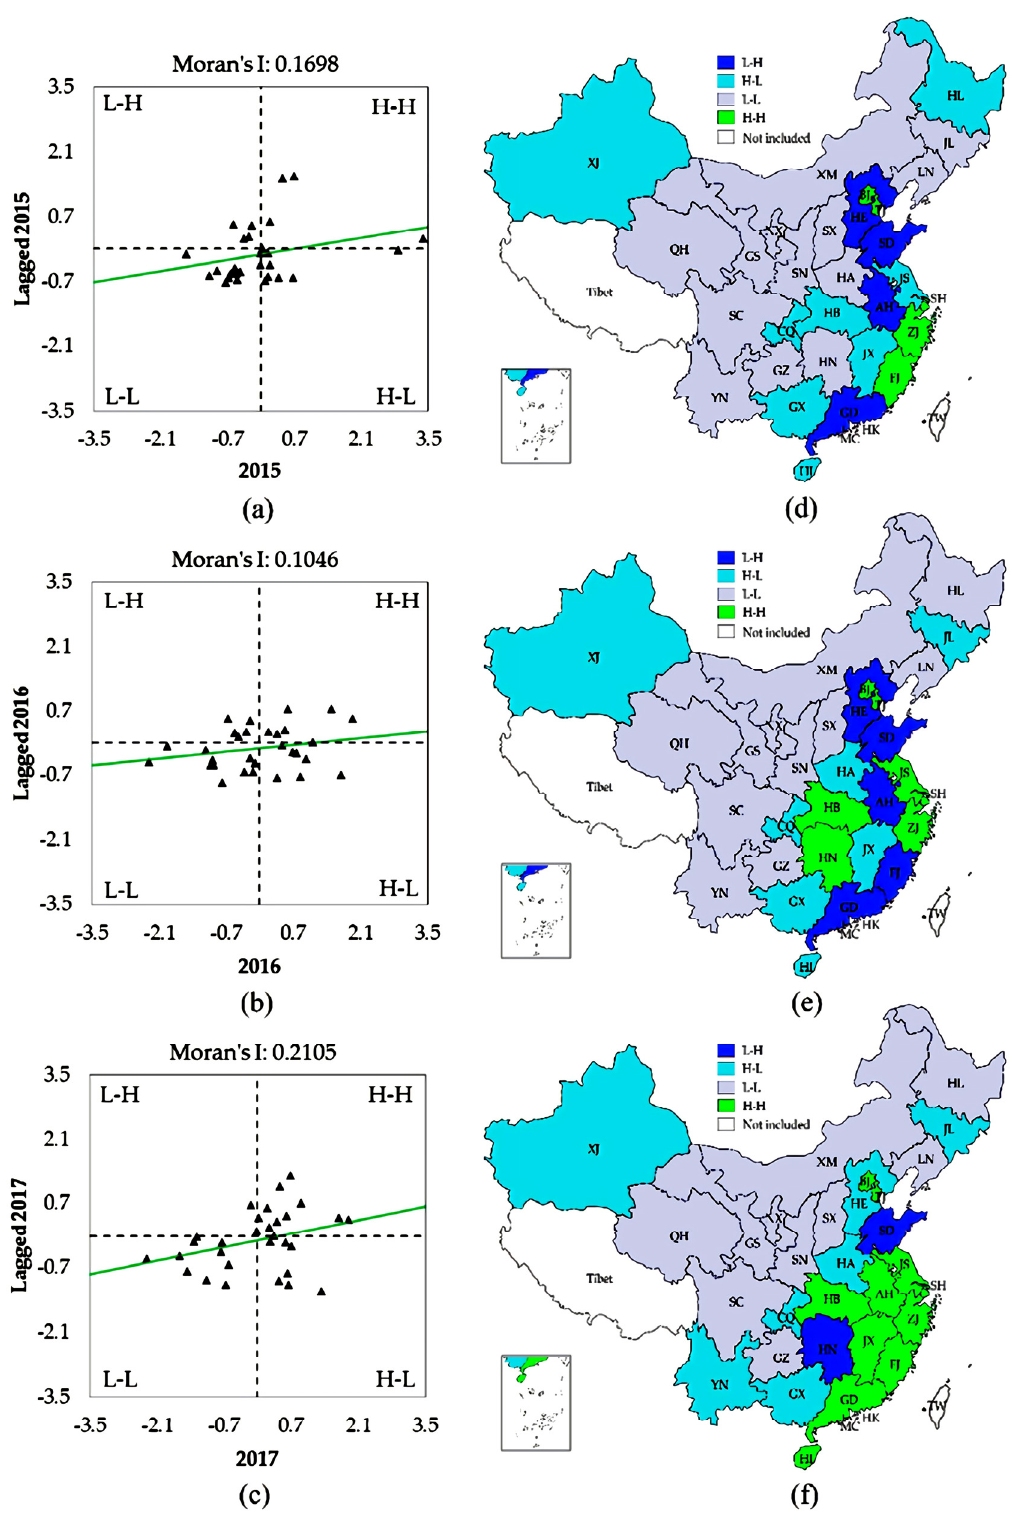
Figure 5. Moran scatterplots of the SPCI: ( a ) 2015, ( b ) 2016, ( c ) 2017; Local Moran’s I clusters of the SPCI: ( d ) 2015, ( e ) 2016, ( f )